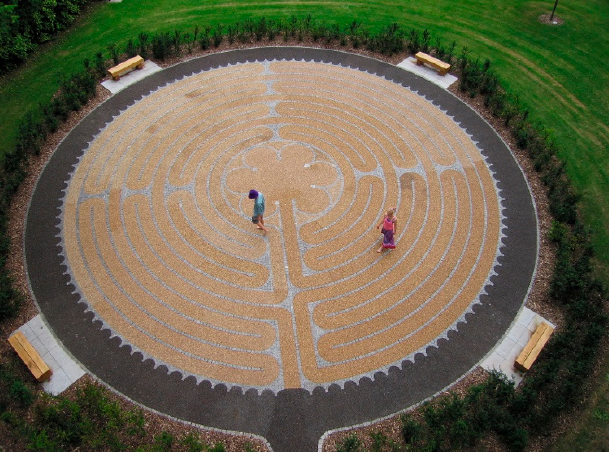
Figure 3. Edinburgh Labyrinth, George Square Gardens, Edinburgh, United Kingdom . Photo by Di